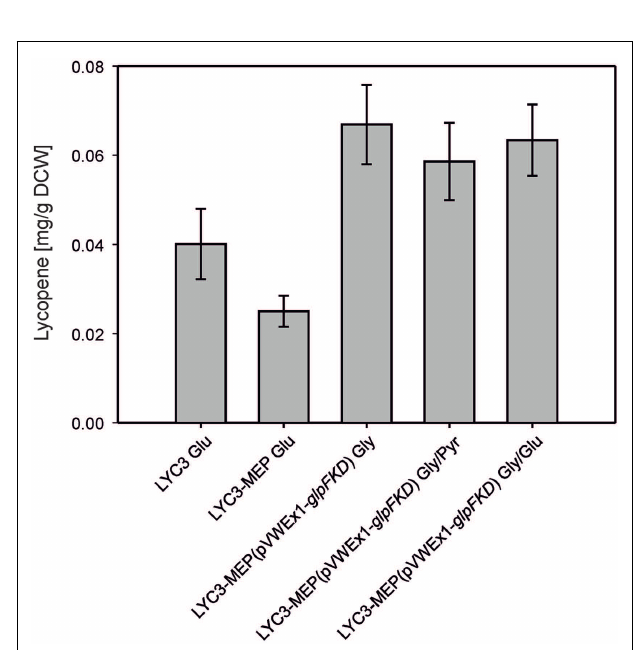
FIGURE 3 | Lyopene production by C. gluamicum LYC3-MEP(pVWEx1- glpFKD ) on glycerol as sole and combined carbon source . LYC3-MEP (pVWEx1- glpFKD ) cells were grown in CGXII minimal medium with 200mM glycerol (Gly), 100mM glycerol + 100mM pyruvate (Gly/Pyr), or 100mM glycerol + 50mM glucose (Gly/Glu), respectively. Expression of glpFKD was induced by 50 µ M IPTG. As reference, lycopene production of the strains LYC3 and LYC3-MEP grown in CGXII minimal medium with 100mM glucose (Glu) is given. Means and standard deviations of three cultivations are